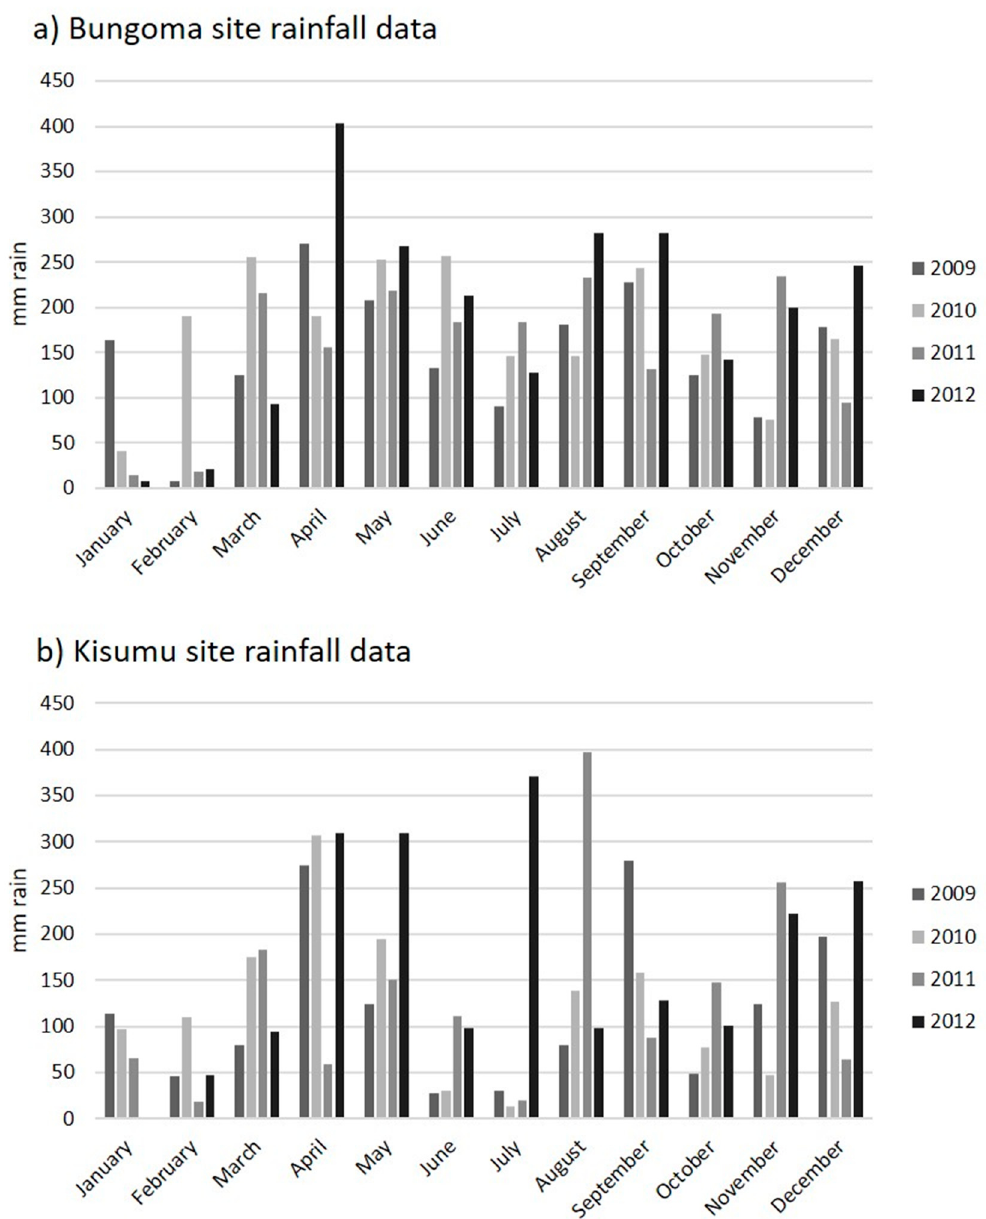
Figure A1. Monthly rainfall data in the study areas, 2009–2012; ( a ) Bungoma site (Kakamega Figure A1 . Monthly rainfall data in the study areas, 2009-2012; ( a ) Bungoma site (Kakamega meteorological station; total annual rainfall 2009–2012 = 1789, 2113, 1876 and 2287 mm, respectively). meteorological station; total annual rainfall 2009-2012 = 1789, 2113, 1876 and 2287 mm, respectively). ( b ) Kisumu site (Kisumu meteorological station; total annual rainfall 2009–2012 = 1426, 1477, 1563, and ( b ) Kisumu site (Kisumu meteorological station; total annual rainfall 2009-2012 = 1426, 1477, 1563, and 2036 mm, 2036 mm, respectively).